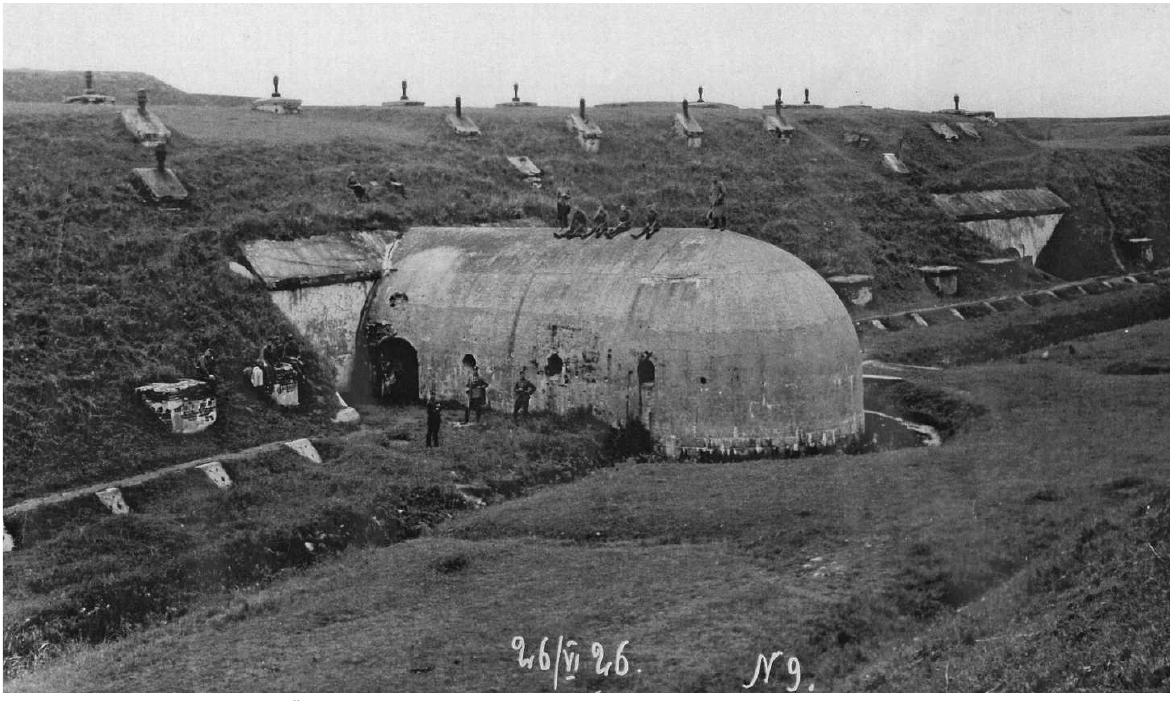
Fig 4. Fort VIII in 1929 (Photo by A. Šulcas from O. Jermolajevas‘ collection)